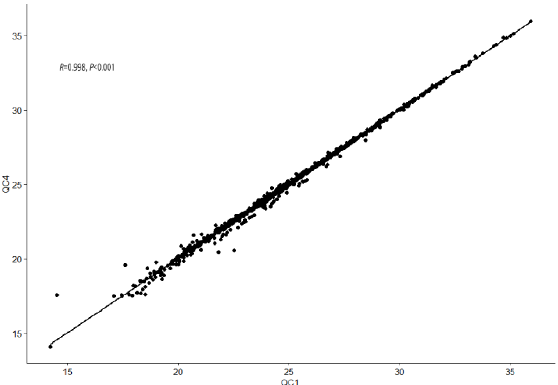
Figure 1. Spearman correlation analysis of the first and last QC samples in the analysis batch. High correlation indicated high data quality of acquired untargeted metabolomics data.